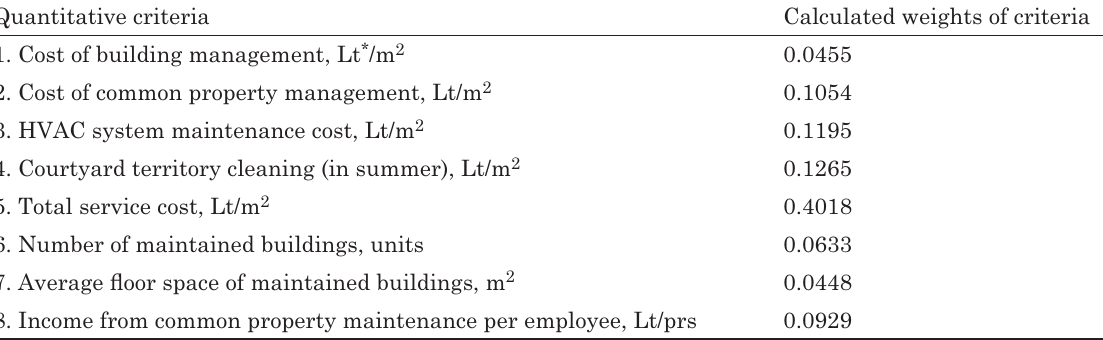
Table 2. Qualitative criteria for evaluating the alternatives Quantitative criteria